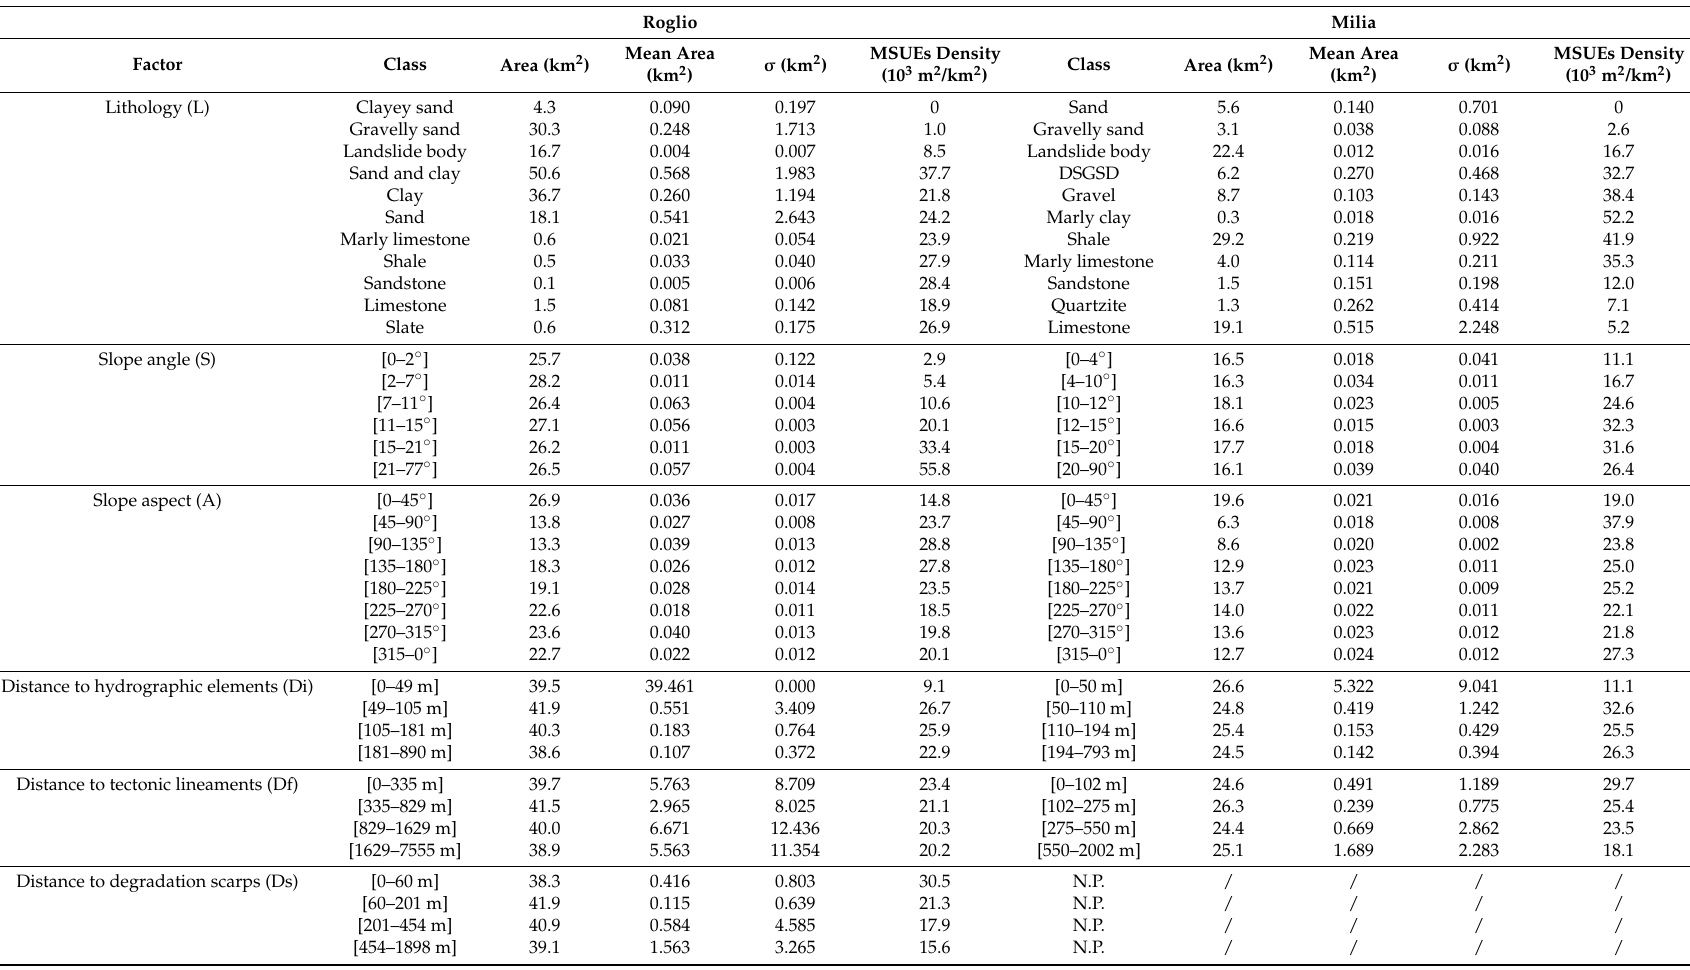
Table 1. Area (km 2 ), mean area, area standard deviation ( σ ), and Main Scarp Upper Edge MSUE density (m 2 /km 2 ) for each class of the factors used in the analysis. The values are reported for each studied